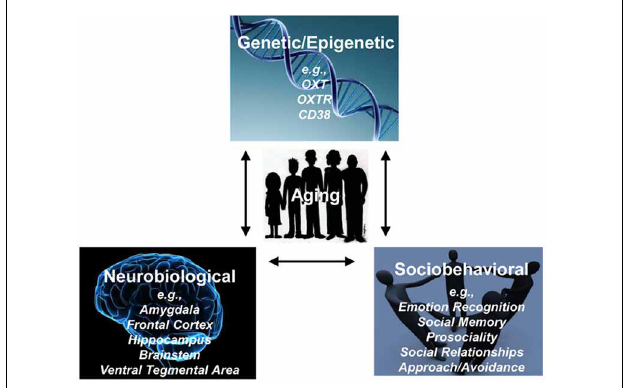
FIGURE 2 | Age-related Genetic, Neurobiological, Sociobehavioral Model of Oxytocin (AGeNeS-OT model).